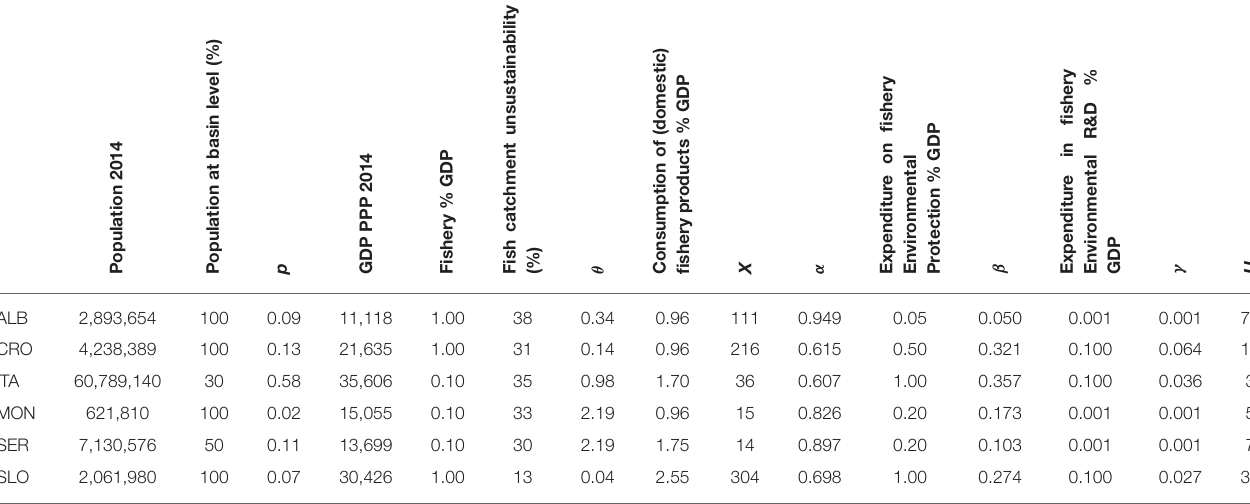
TABLE 4 | The dataset for the case study in the Adriatic Sea.